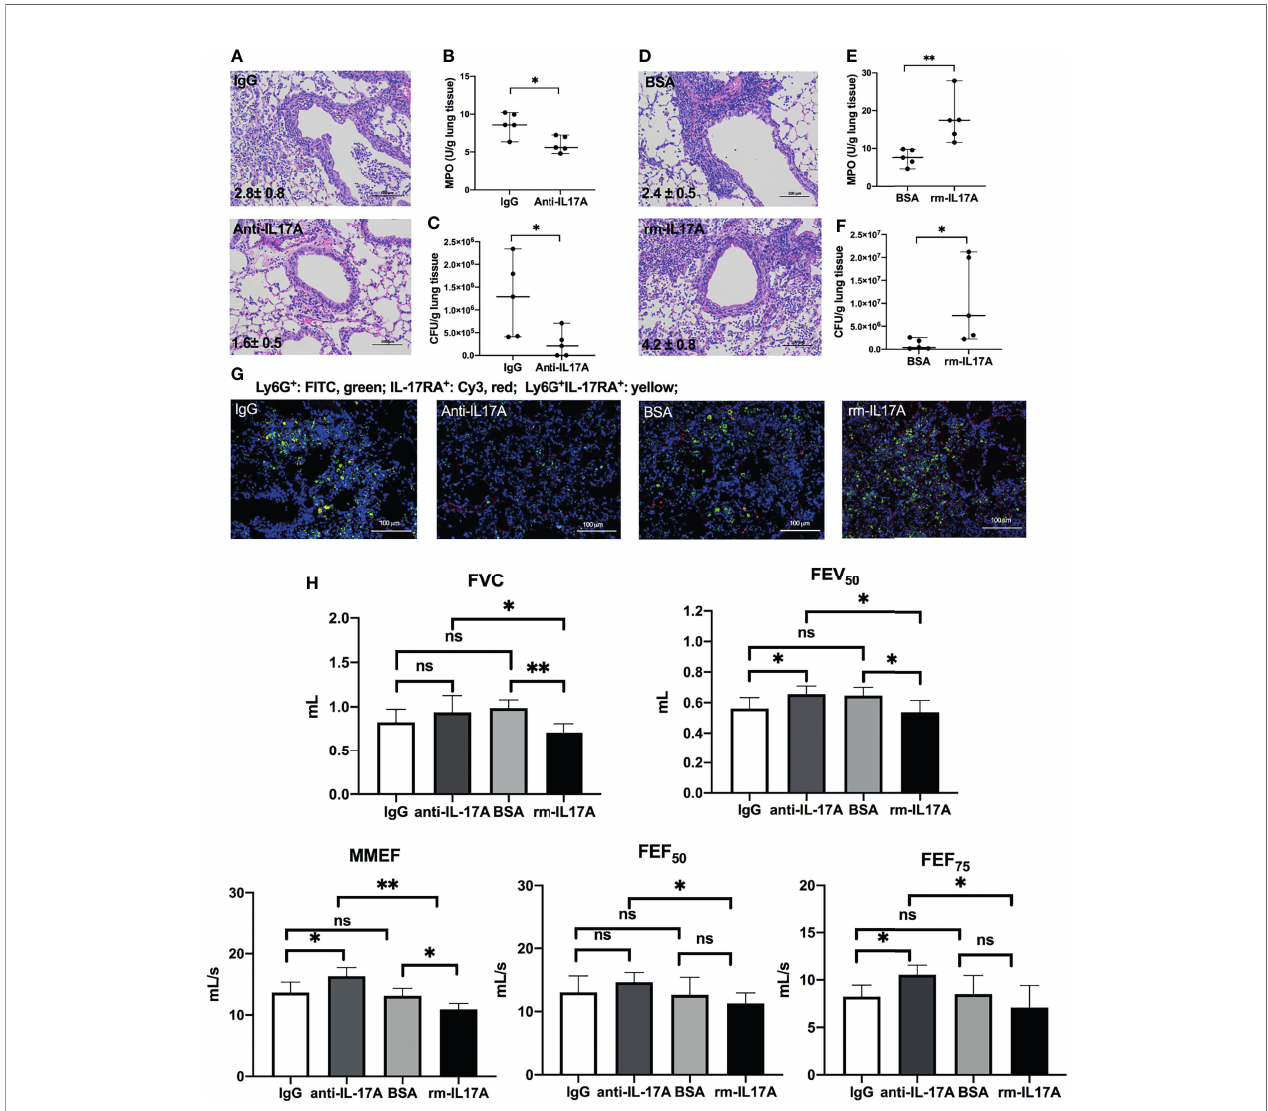
FIGURE 3 | IL-17A-signaling promoted lung injury in P. aeruginosa -infected COPD mouse models. COPD mouse models were intraperitoneally injected with IL- 17A – neutralizing antibody (2 mg/kg) or recombinant-IL-17A (1.6 mg/kg) 4 h before the inoculation with 1.0 × 10 5 CFU P. aeruginosa . Mouse IgG and BSA serve as controls, respectively. Lungs were excised, sectioned and stained with hematoxylin and eosin (internal scale bar = 100 m m) at one day post inoculation (A, D) . The numbers within each lung microphotograph are the in fi ltrate scores assigned. MPO unit determination (B, E) , bacterial plate counting (C, F) were performed. The lung sections were immuno fl uorescently stained with anti-IL-17RA (red) and anti-Ly6G (green), and DAPI (blue) for nuclei (G) . Internal scale bar = 100 m m. The results of spirometry tests, including FVC, FEV 50 , MMEF, FEF 50 , and FEF 75 were compared among different groups (H) . Data are presented as mean ± SD ( n = 5). * P < 0.05, ** P < 0.01, ns, non-signi fi cant. COPD, chronic obstructive pulmonary disease; MPO, myeloperoxidase; CFU, colony-forming units; BSA, bovine serum albumin; IL, interleukin; FVC, forced vital capacity; FEV 50 , volume expired in the fi rst 50 ms of fast expiration; MMEF, maximal mid-expiratory fl ow; FEF 50 , forced expiratory fl ow at 50% FVC; FEF 75 , forced expiratory fl ow at 75%